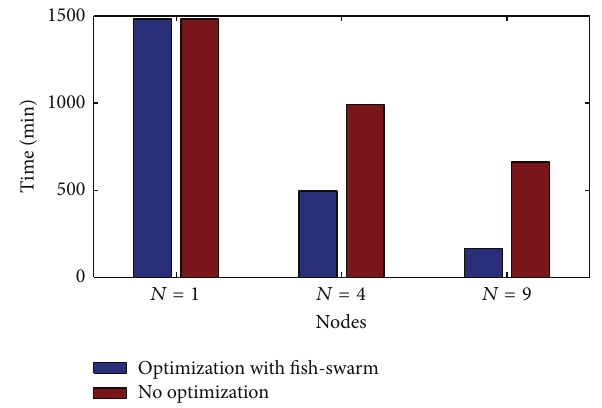
Figure 12: Comparison between the optimized formation and the formation with no